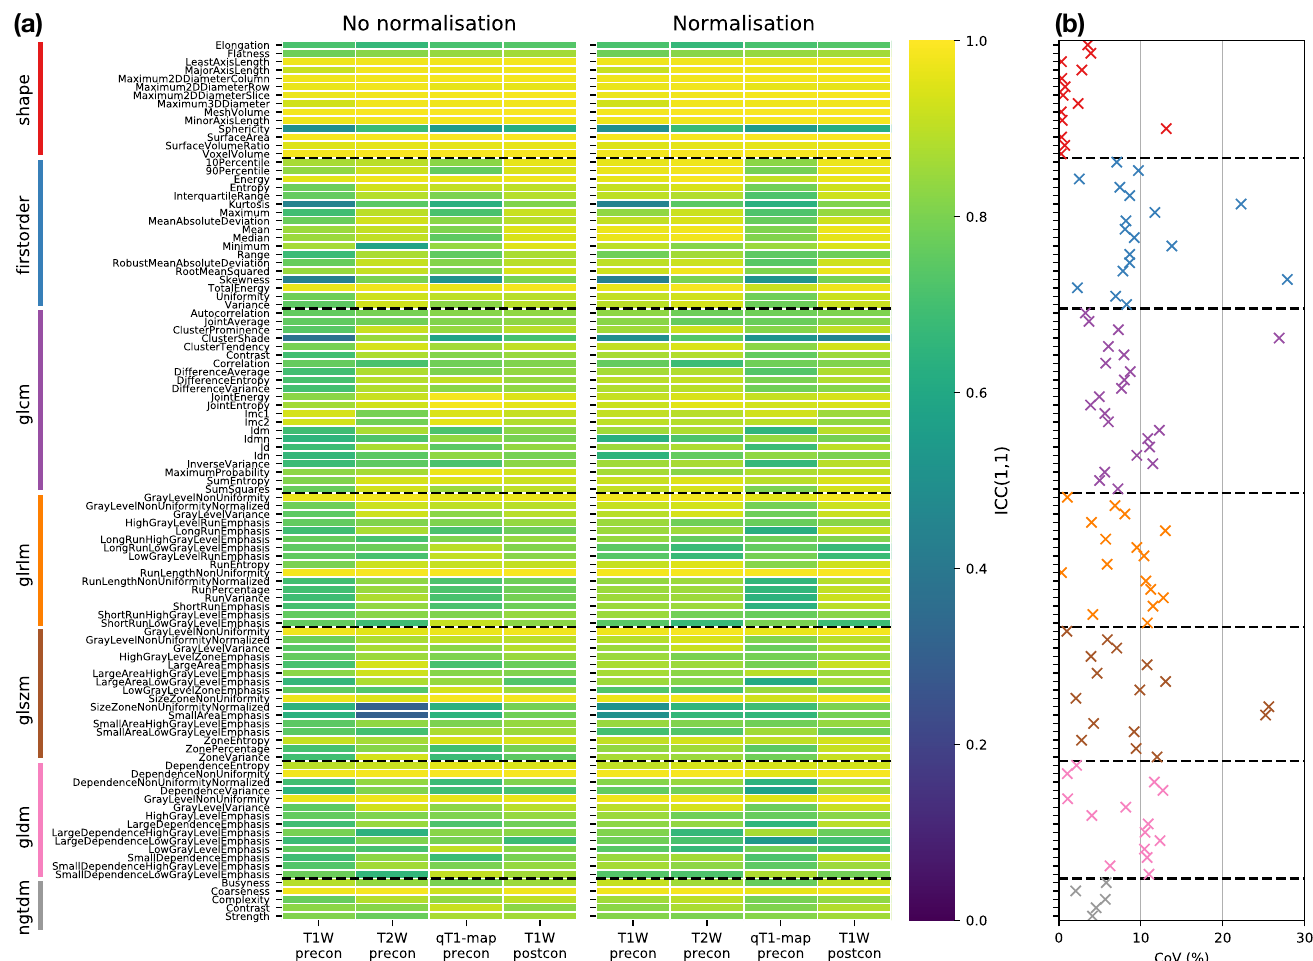
Figure 4. ICC point estimates for all features (rows), for each sequence (columns), from images without (left panel) and with (right panel) normalisation. Horizontal dashed black lines separate features in different classes.